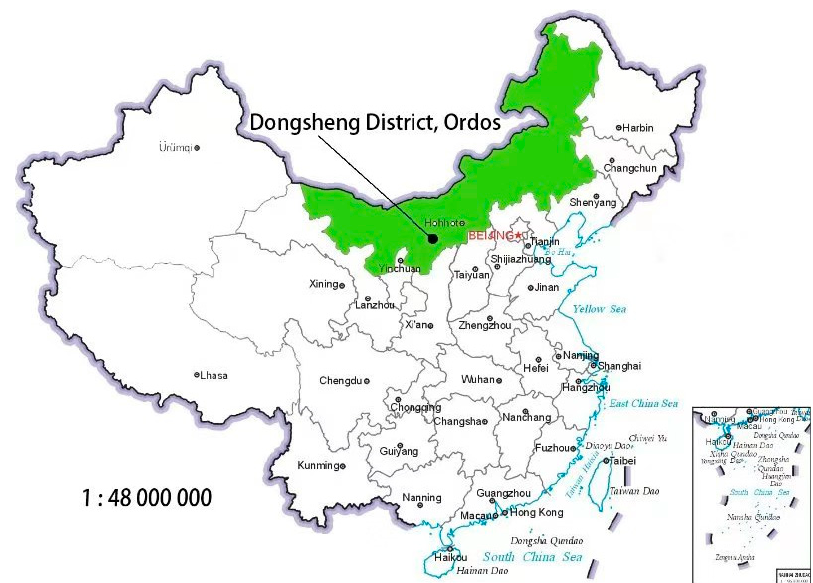
Figure 1. Location of CG samples in Ordos, China.